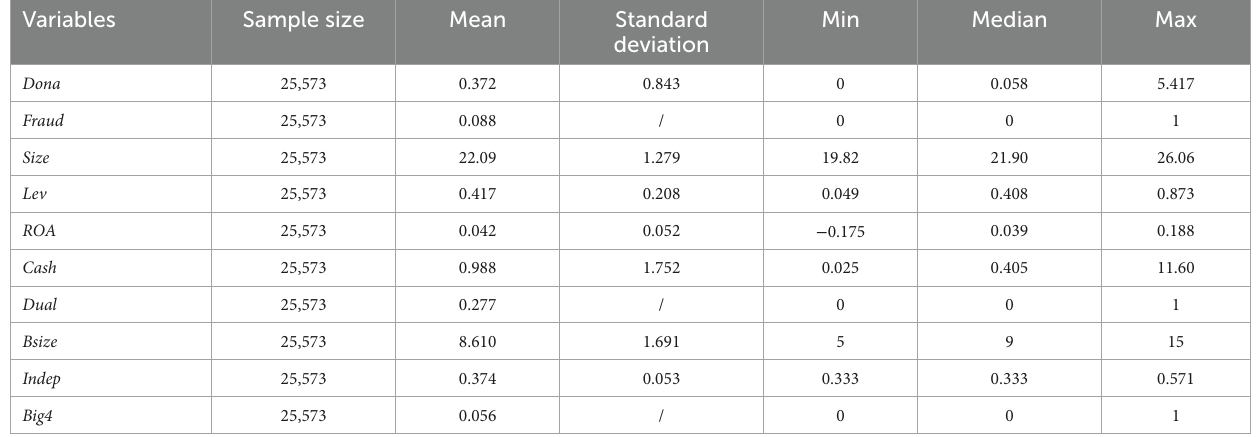
TABLE 2 Descriptive statistics.